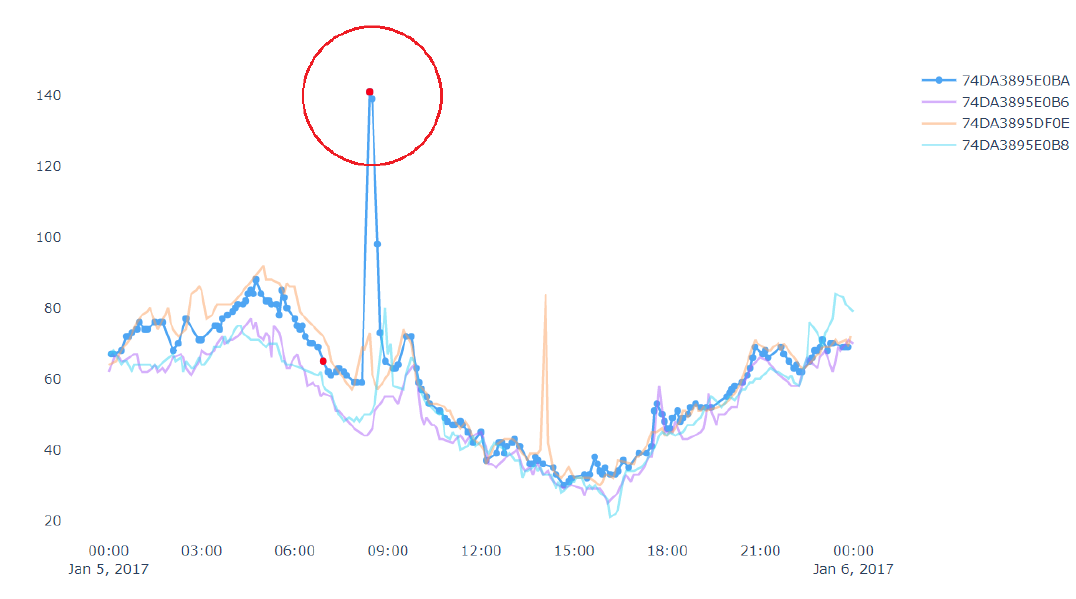
Figure 10. An example of a spatial (and temporal) outlier.